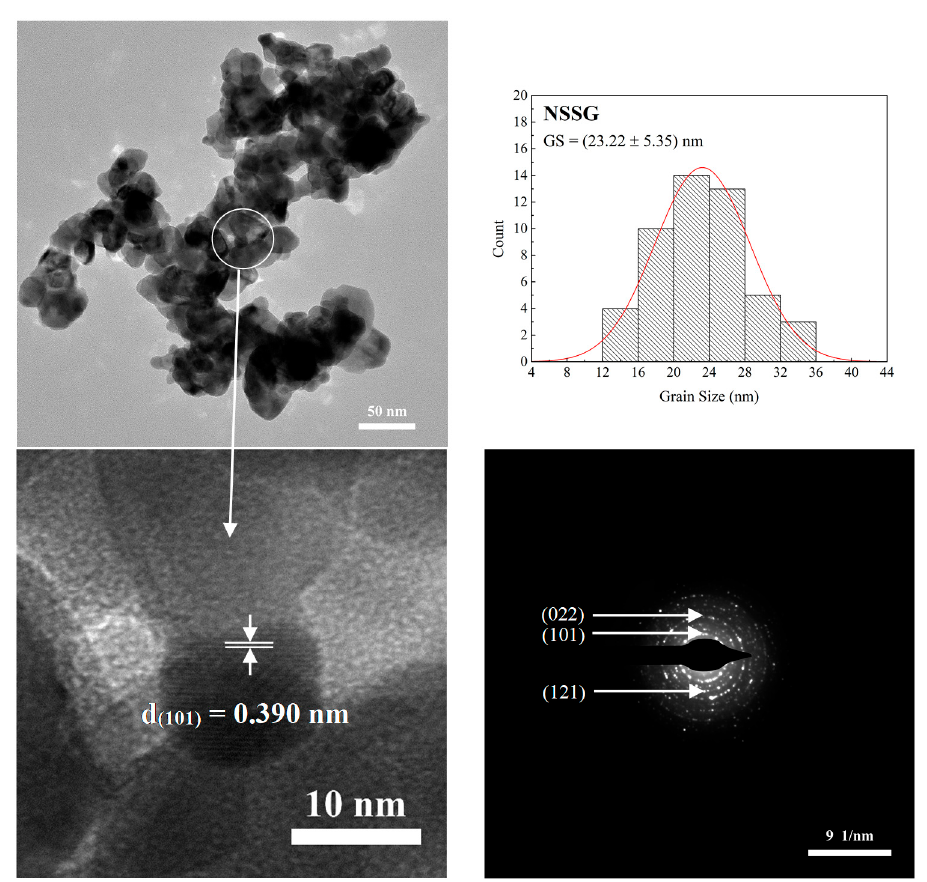
Figure 3. TEM micrographs, grain size distribution histogram, and SAED of NSSG.